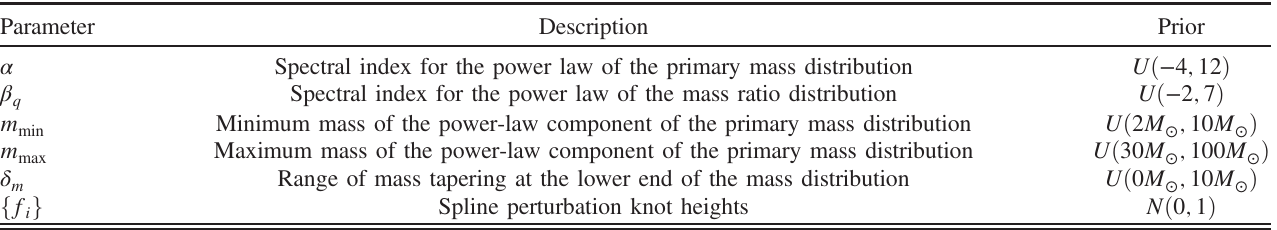
TABLE VII. Summary of P OWER L AW +S PLINE model parameters. Parameter